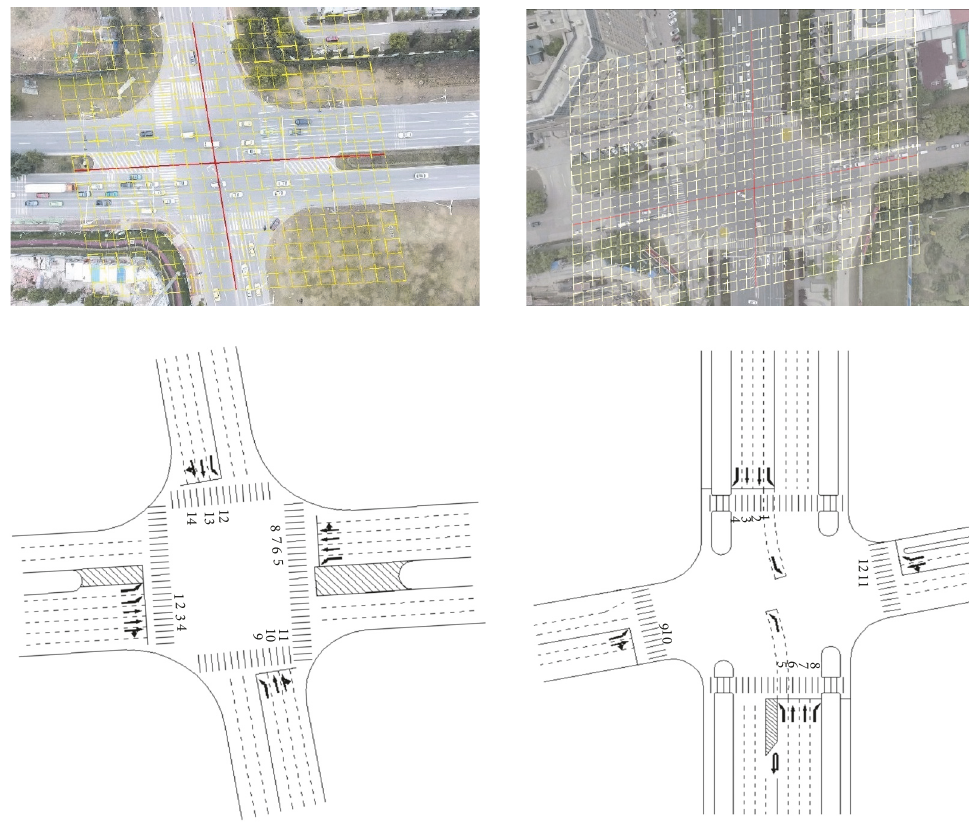
Figure 1: Aerial photos and sketches of the testing site (left) and the validation site